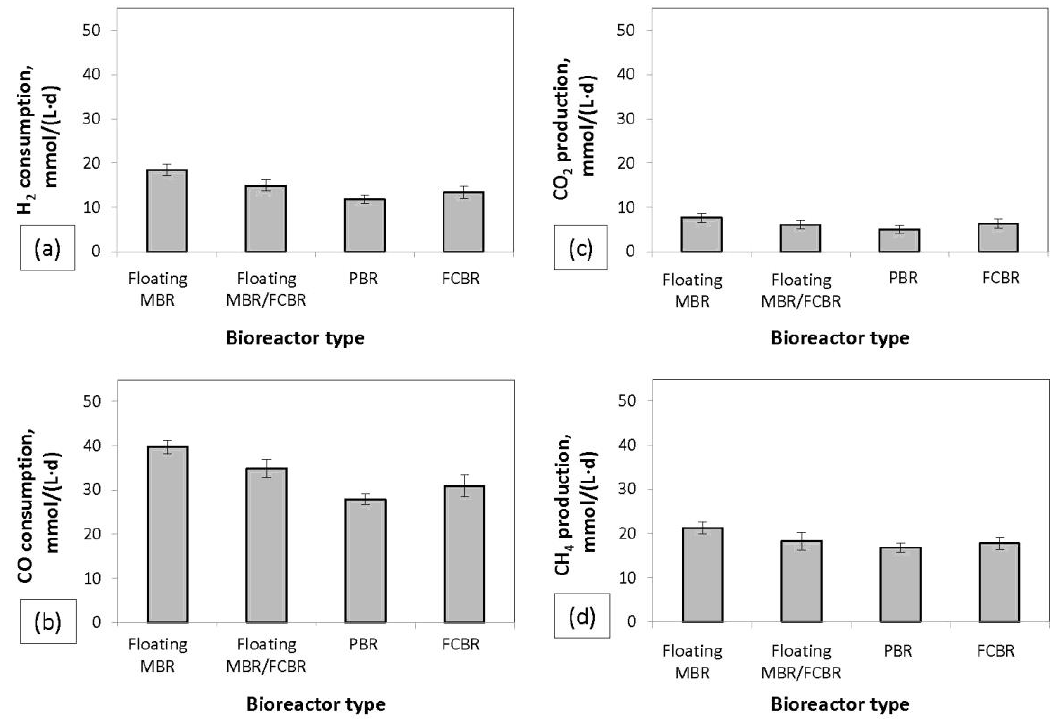
Figure 4. Syngas biomethanation in floating MBR, floating MBR/FCBR, PBR, and FCBR during continuous syngas feeding. Consumption of ( a ) H 2 and ( b ) CO and production of ( c ) CO 2 and ( d ) CH 4 in mmol/(L·d).